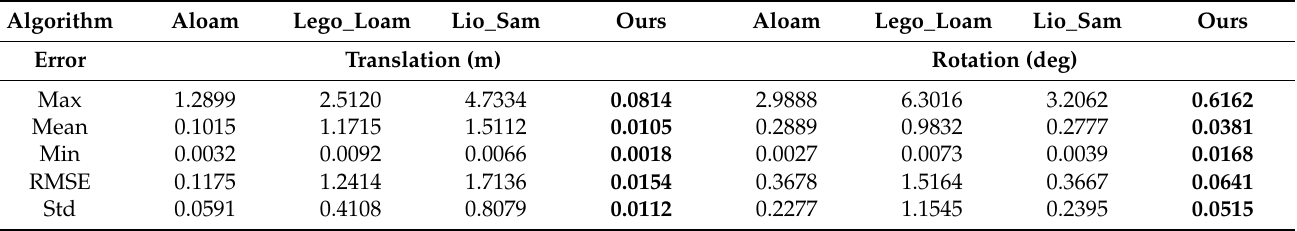
Figure 4. Comparison between the trajectory error and the true value produced by the four different, they should be listed as: ( a ) translation error; ( b ) rotation error. To further refine the comparison experiments, we analyzed the maximum deviation, mean deviation, minimum deviation, root mean square error and standard deviation of the KITTI datasets 2011_09_30_drive_0028 sequence for the four different algorithms for each relative translation and rotation, as shown in Table 3. The best results are shown in bold. Table 3. Error statistics of relative translations and rotations between the four algorithms and the true